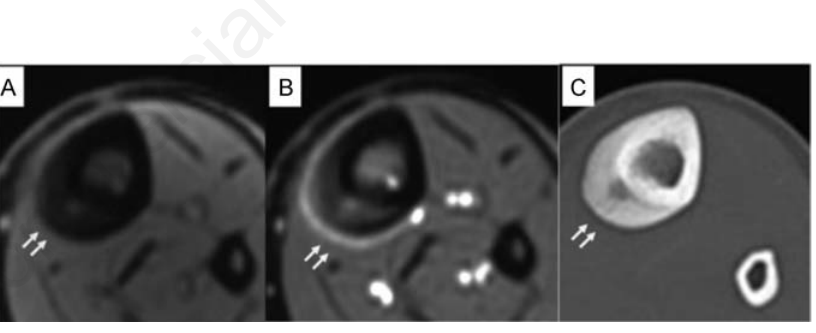
Figure 2. A) Fat-suppressed T1-weighted magnetic resonance image showing a 10-mm circumscribed abnormality located in the cortex of the tibia. B) Gadolinium enhanced fat-suppressed T1-weighted image showing a circumscribed signal abnormality in the cortex of the tibia that was moderately enhanced. C) Axial computed tomography image of the patient clearly showing an osteolytic lesion corresponding to the abnormality seen on magnetic resonance imaging.